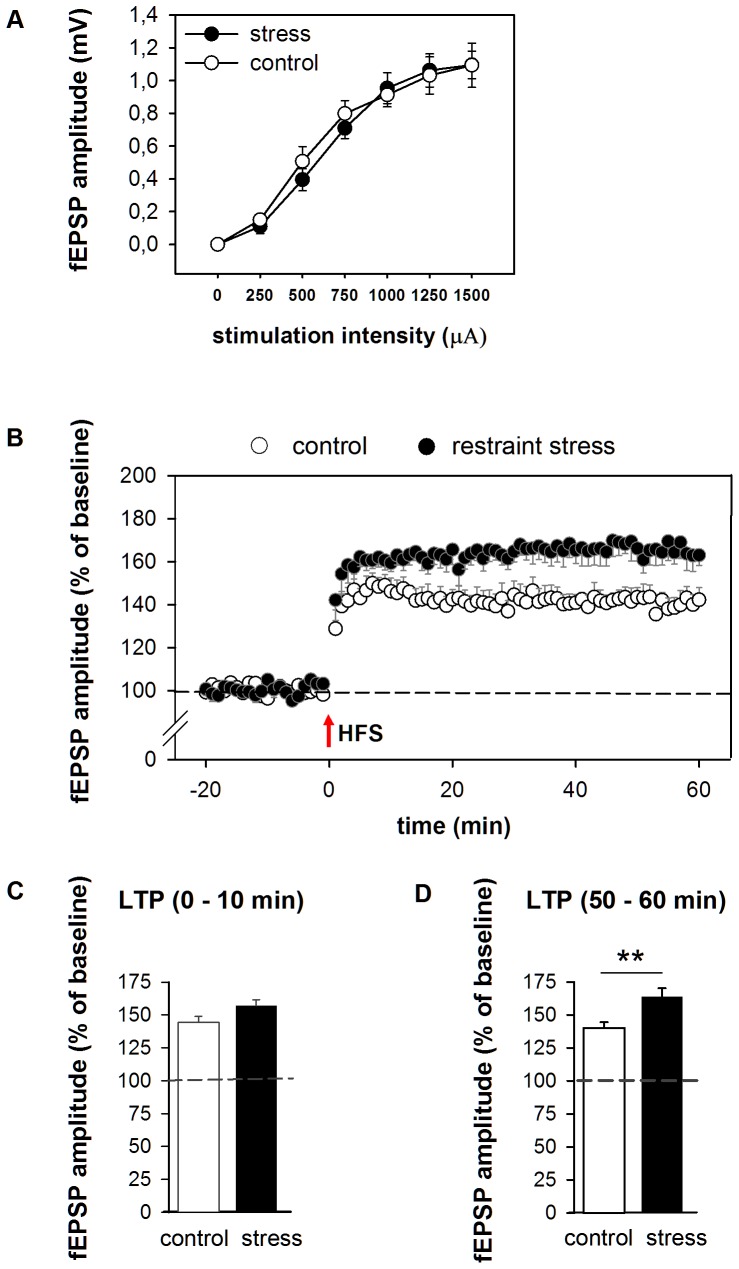
The effect of restraint stress on baseline transmission and LTP.
A Input-output curves constructed from the fEPSP amplitude vs increasing stimulation intensities at the BLA from brain slices of control (open symbols, n = 8) and restrained stressed mice (filled symbols, n = 7). No significant differences in stimulus-response relationships or maximal fEPSP amplitude were found. B HFS (1×100 Hz, 1 s) of the LA afferents resulted in stable LTP at BLA synapses in slices of control mice which was more pronounced in stressed mice. Averaged mean values during C 0–10 min and D 50–60 min of the post-tetanus recording period indicate that compared to controls (white columns), late LTP is significantly enhanced in stressed mice (black columns). Dashed line indicate pre-tetanus baseline levels. Error bars indicate SEM. ** p<0.01.